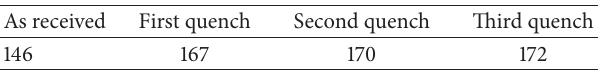
Table 2: Vickers hardness number (VHN) for the test specimens.